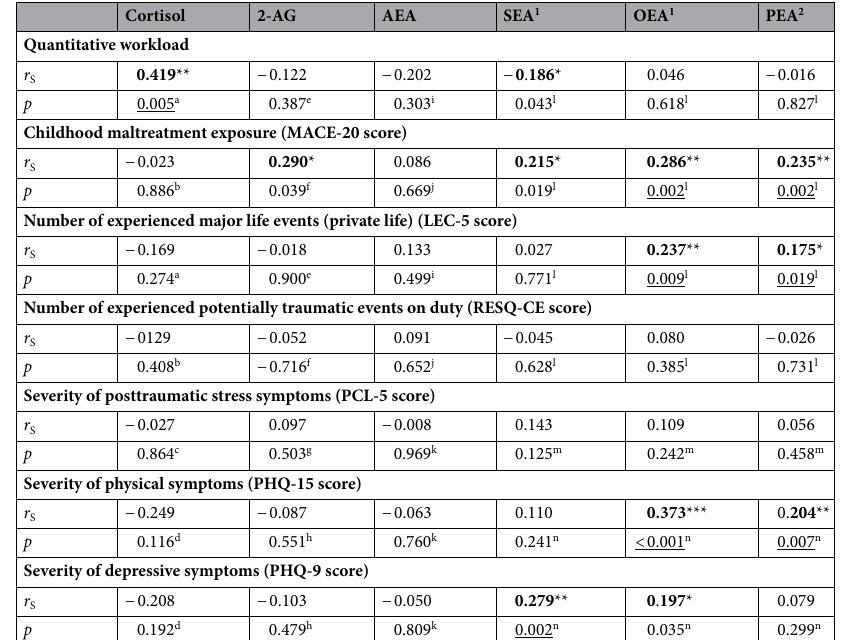
Table 2. Results of bivariate and semi-partial correlation analyses. * p < 0.050, ** p < 0.010, *** p < 0.001, two- tailed. Bold-faced correlation are significant. Underlined p -values are significant after correction with false discovery rate. Semi-partial Spearman correlations were computed to control the associations of 1 sex and hair treatment or 2 sex, age, and hair treatment with the respective hair concentration. Sample sizes varied due to differing number of detected steroids and lipids in hair, as well as due to missing values in sociodemographic and psychological data (for details see the methods section). Each correlation was analysed using all respectively available data of the whole study cohort: n = a 44, b 43, c 42, d 41, e 52, f 51, g 50, h 49, i 28, j 27, k 26, l 60, m 59, n